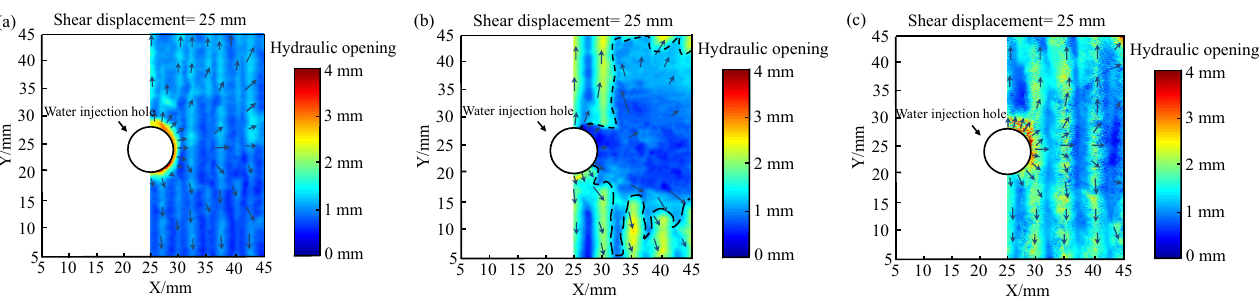
Figure 12. Schematic diagram of the development of hydraulic fractures in a structural plane (shear displacement = 25 mm).